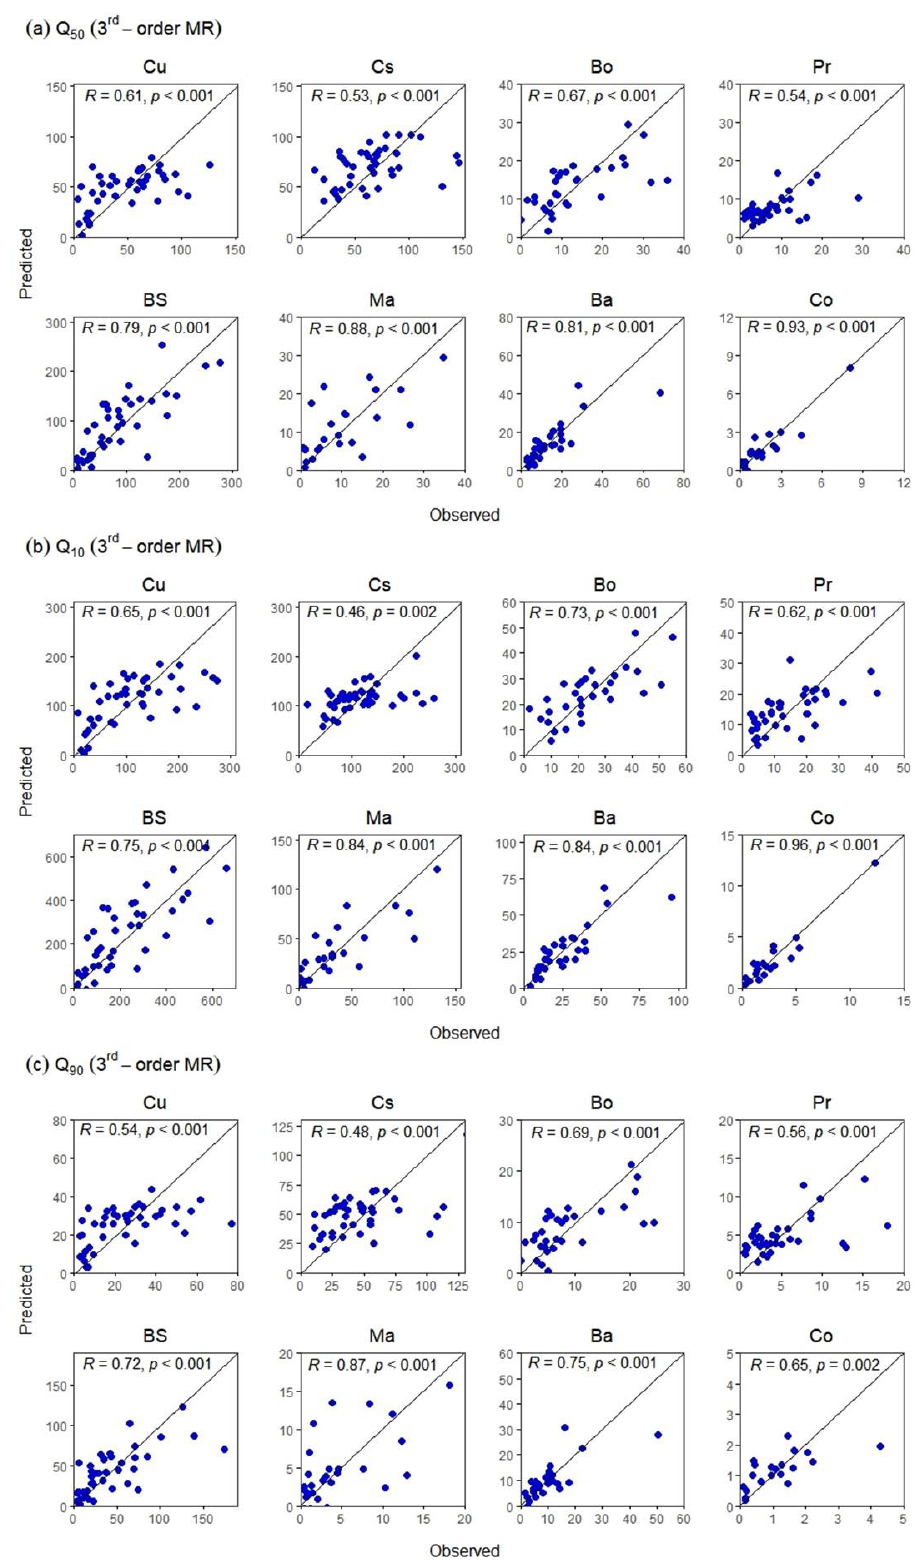
Figure A2. Scatterplots between the predicted (Niño 3.4-DMI, third-order MR, SON a set) and the observed values (in m 3 /s) of the flow regimes ( a ) Q 50 , ( b ) Q 10 , and ( c ) Q 90 for all rivers in this study.